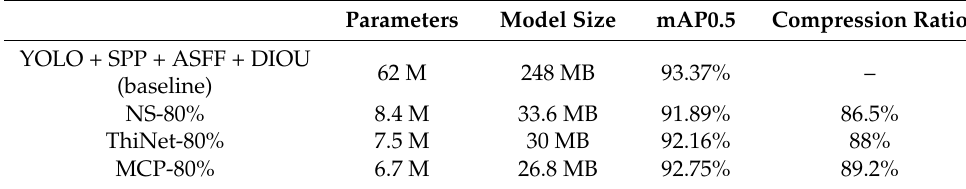
Table 5. Comparison of the channel pruning